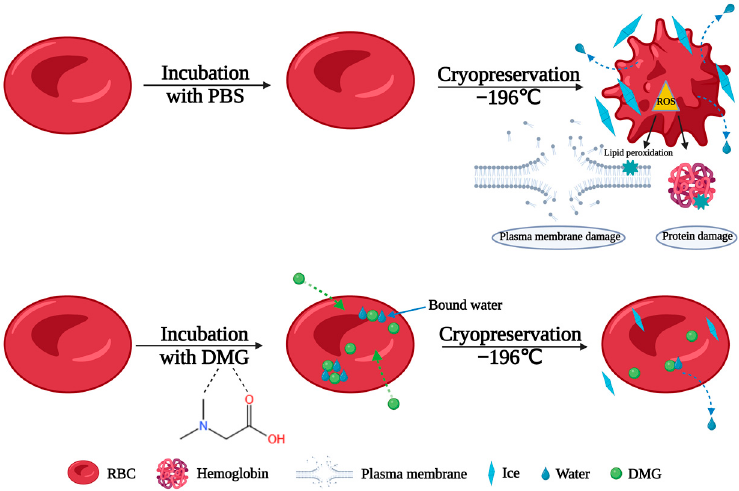
Figure 7. The proposed mechanism of DMG during